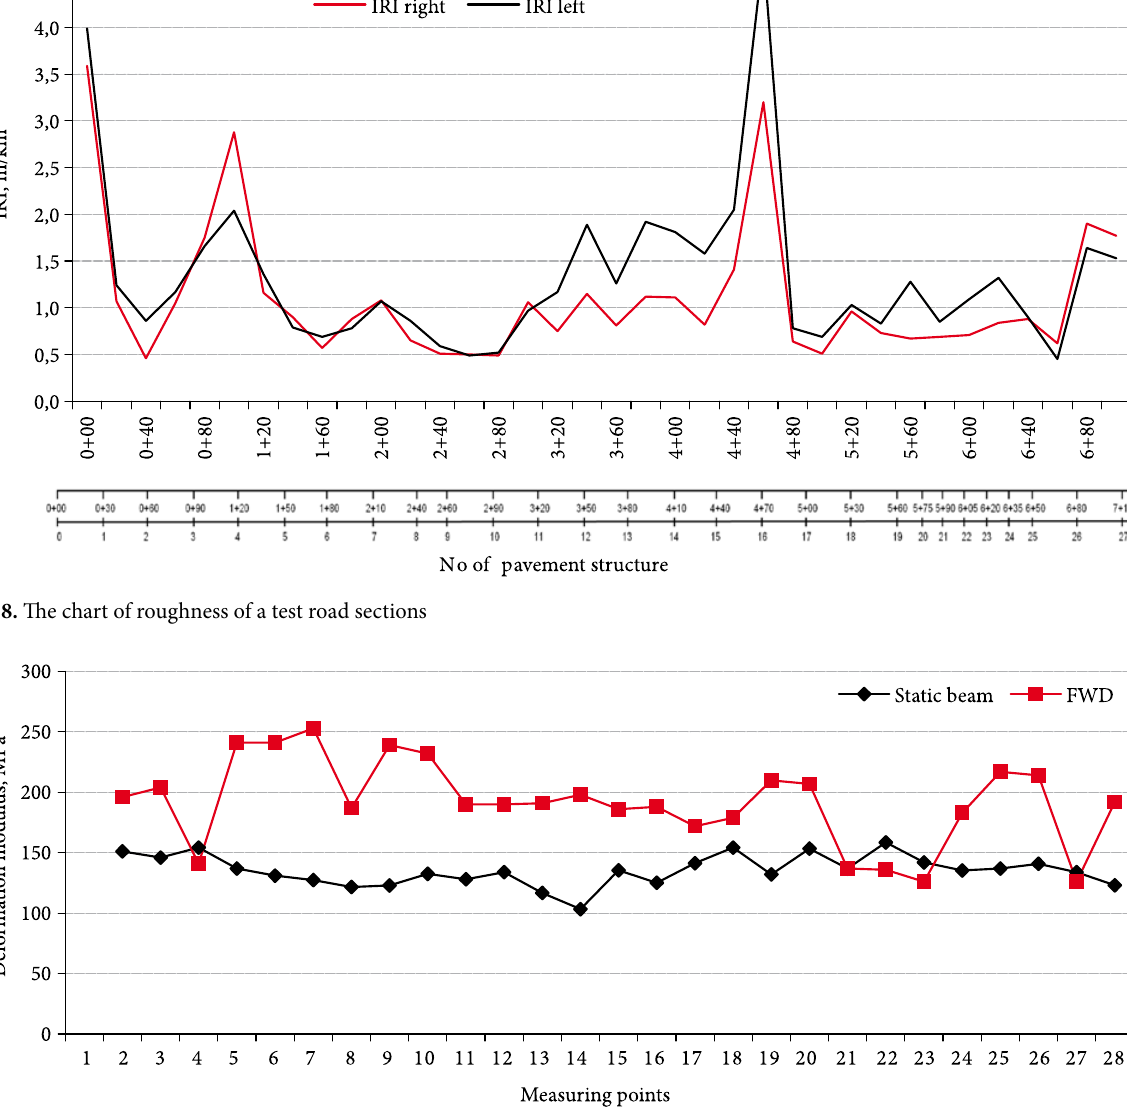
fig. 9. The chart of ruts of a test road